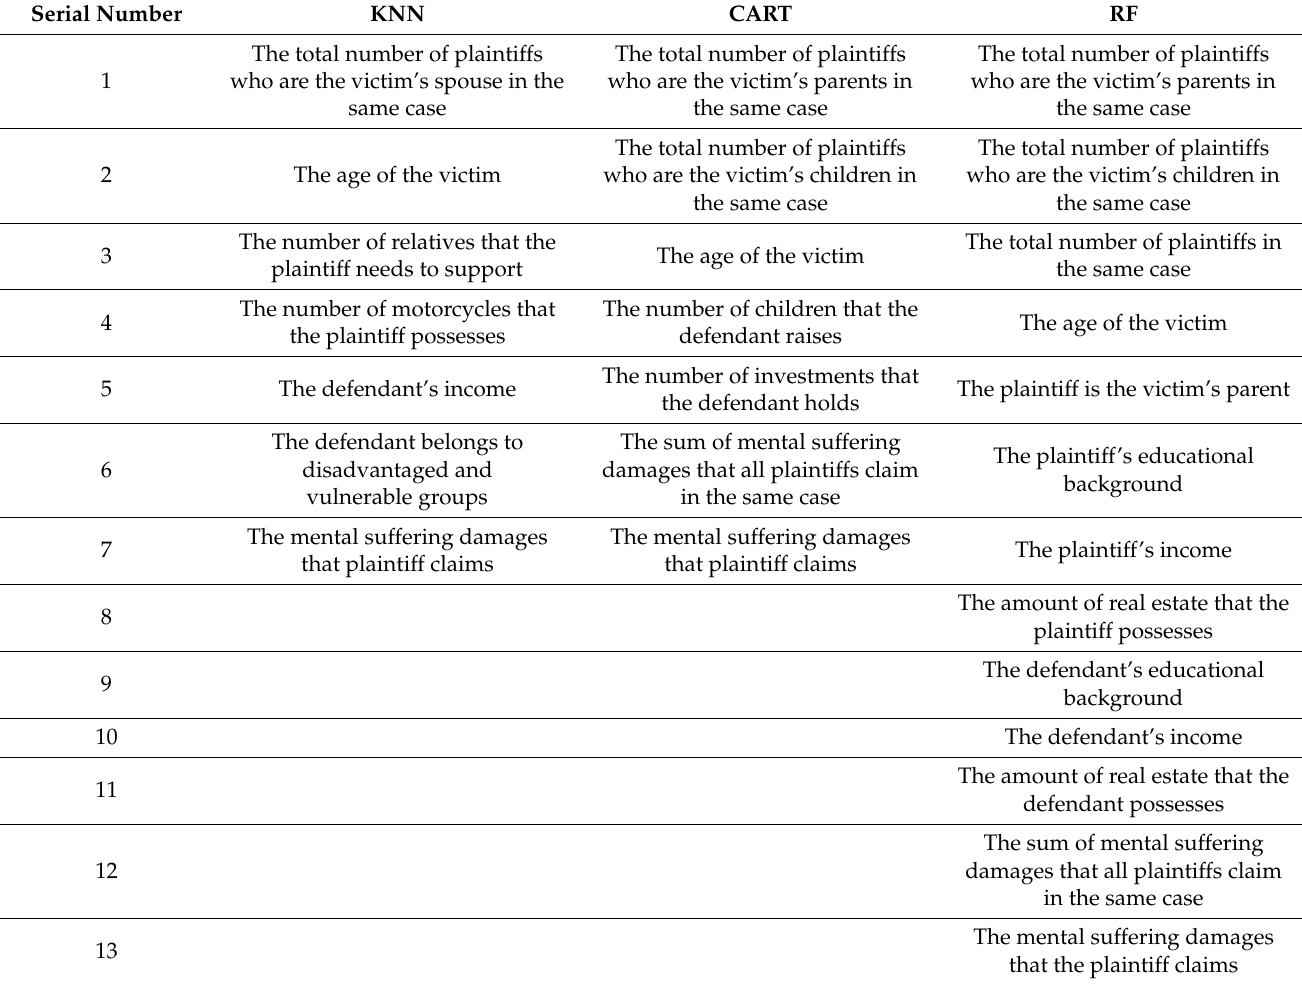
Table 9. The best feature subsets based on different learning